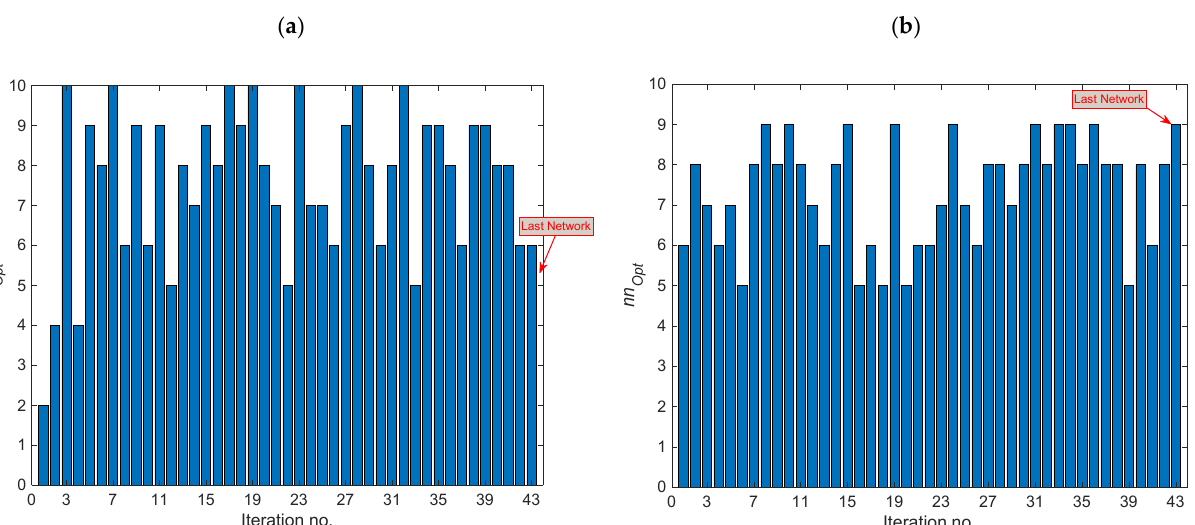
Figure 11. Selecting the optimal number of sequential auto-associative neural networks ( nn Opt ) at each iteration before terminating the iterative process of the ODTL algorithm: ( a ) HMC-ODTL-EMSD, ( b ) SLS-ODTL-EMSD.